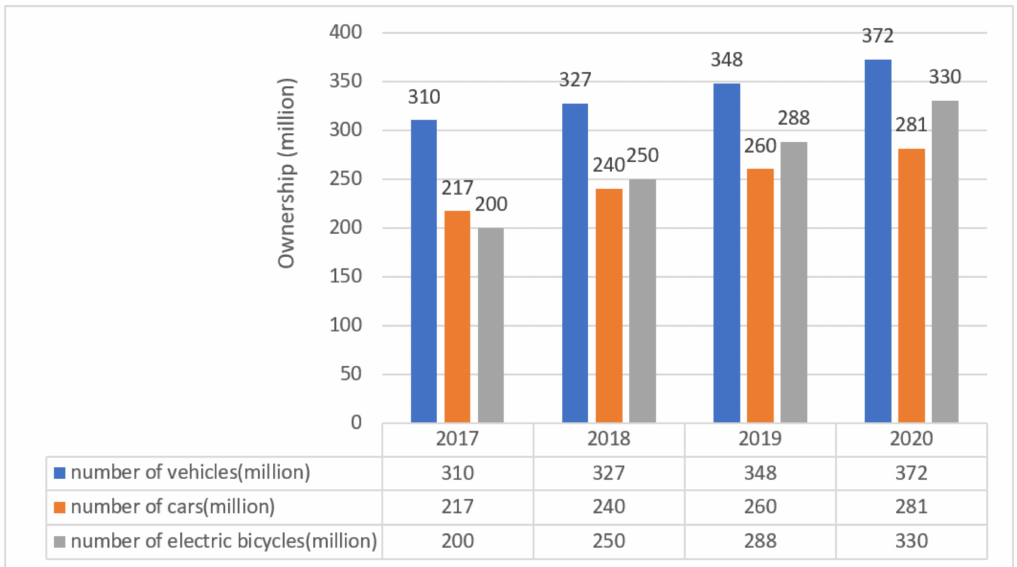
Figure 1. The inventory of motor vehicles and electric bicycles in China from 2017 to 2020.